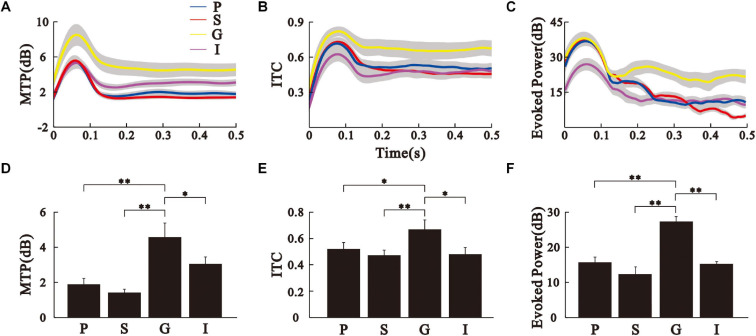
Comparison of MTP, PLF, and evoked power between the different AC layers. (A–C) time function of MTP, PLF, and evoked power of the different AC layers averaged over eight animals. Sold line represents mean, shade area represents SE. (D–F) Bar graph shows the mean and SE of MTP, PLF, and evoked power values averaged across the 35–45 Hz frequency and 0.2–0.5 s post-stimulus time window. ∗∗p < 0.01, ∗p < 0.05, Kruskal–Wallis test followed by Tukey’s multiple comparison.